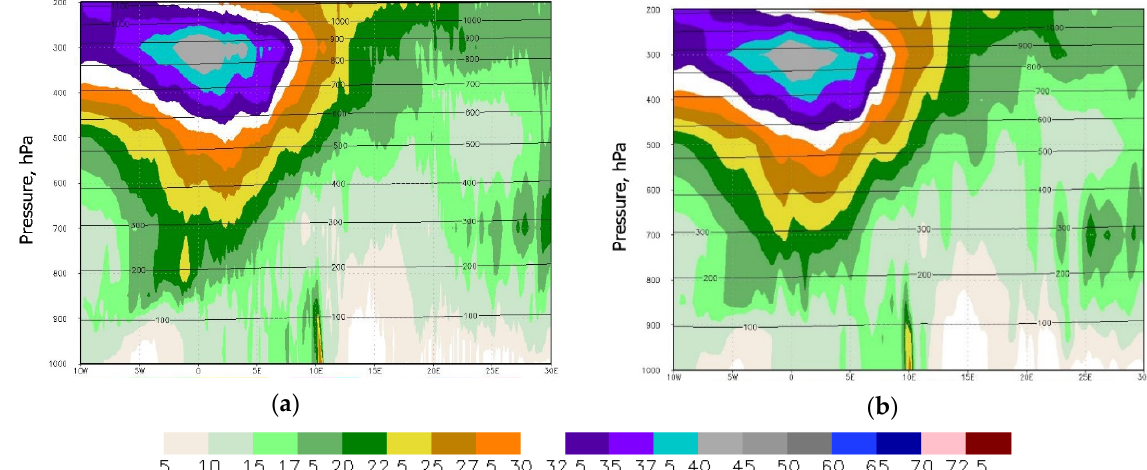
◦ N. Valid time, 08:00 UTC 20 March